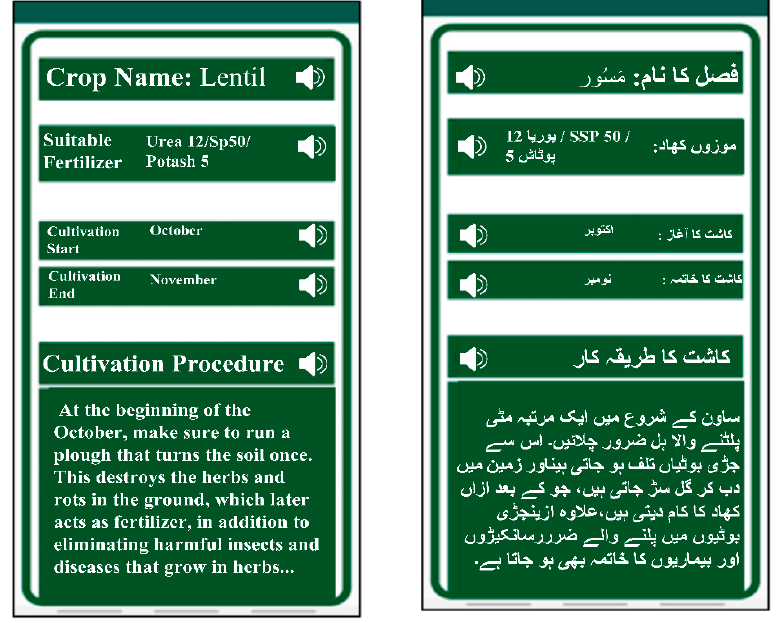
Figure 6. Land Preparation and Cultivation.